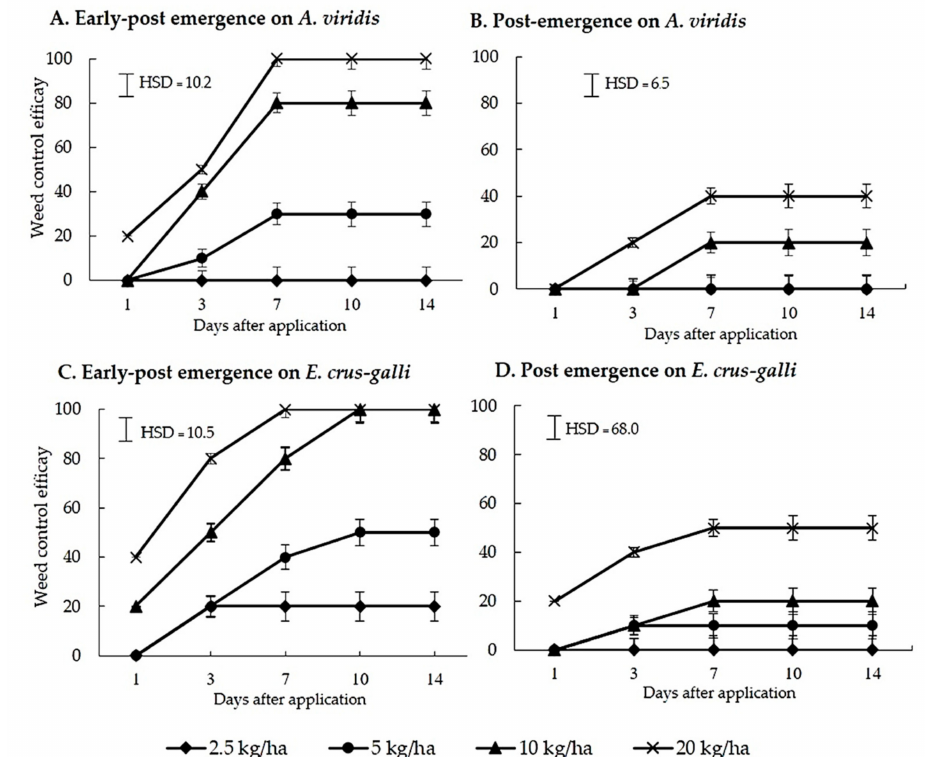
Figure 4. Visible weed control efficacy against A. viridis and E. crus-galli at various days after early post- and post-emergence spray application of CH product under pot experiment in glasshouse conditions. Means expressed error bar ( ± SE) with four replicates. Tukey’s HSD range test at p < 0.05 identified any difference between means of treatments.